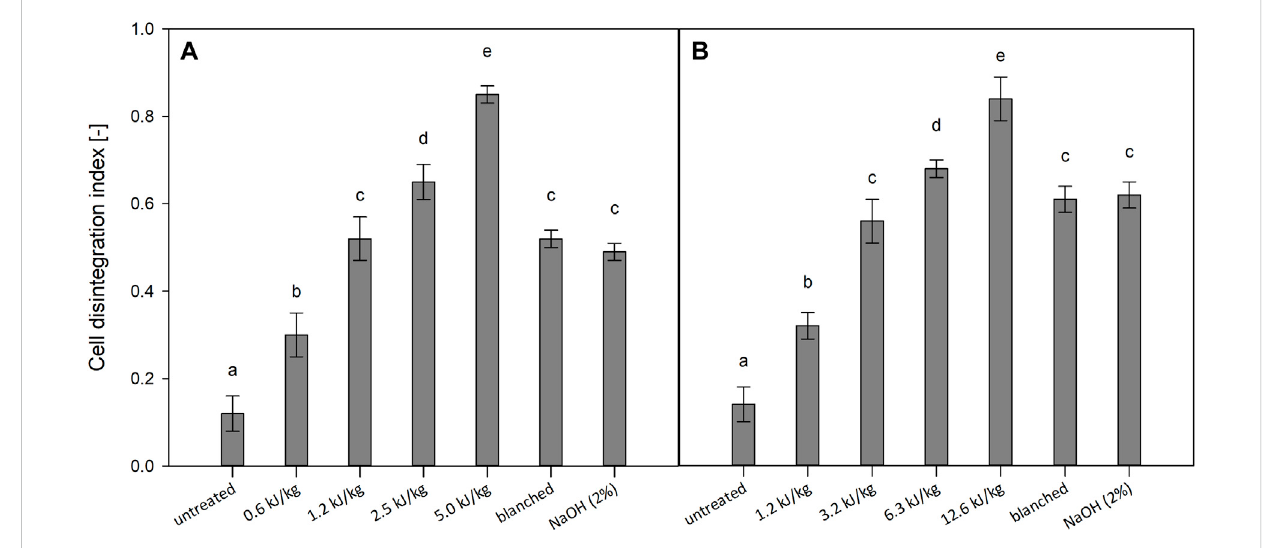
FIGURE 1 Cell disintegration index of PEF treated, blanched and lye peeled tomatoes (A) and kiwi fruits (B) . Signi fi cant differences are indicated by different letters ( p <